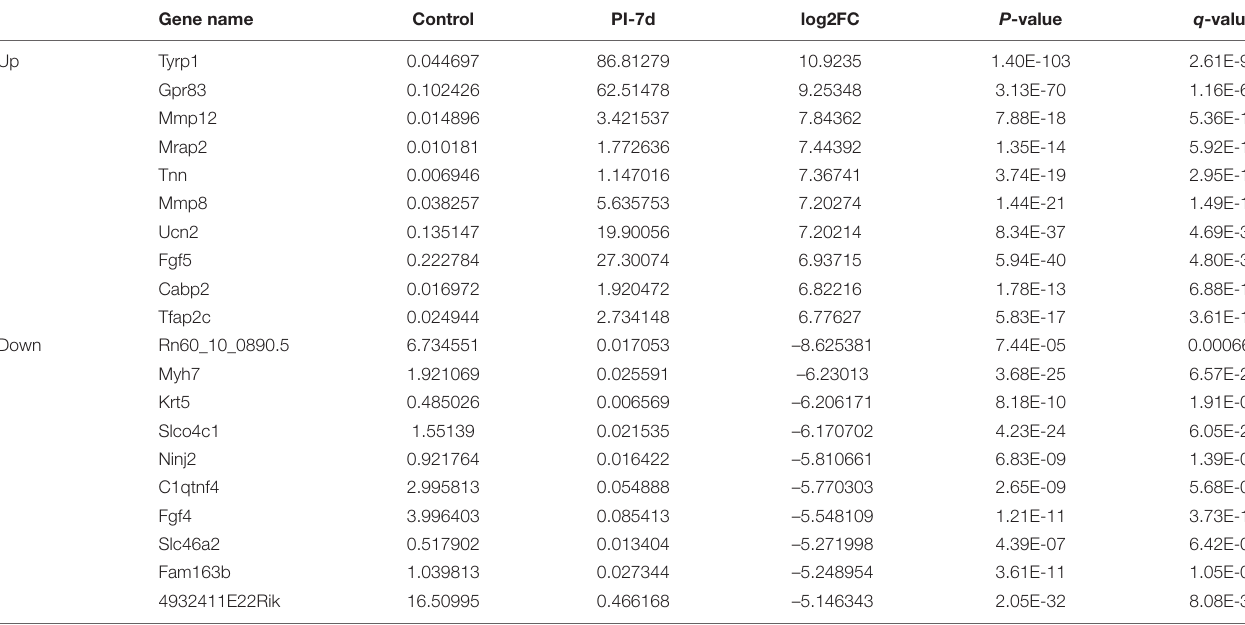
TABLE 5 | Top 10 up/down regulated DEmRNAs 7 days after crush